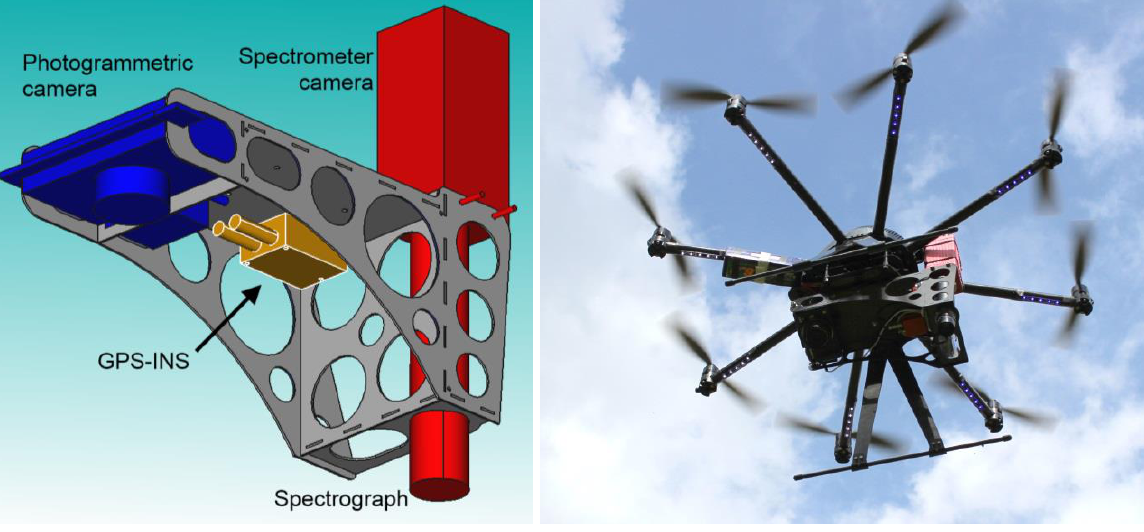
Figure 1. Schematic figure of the HYMSY frame and main components ( Left ) Photo of HYMSY mounted on an Aerialtronics Altura AT8 v1 octocopter UAV ( Right